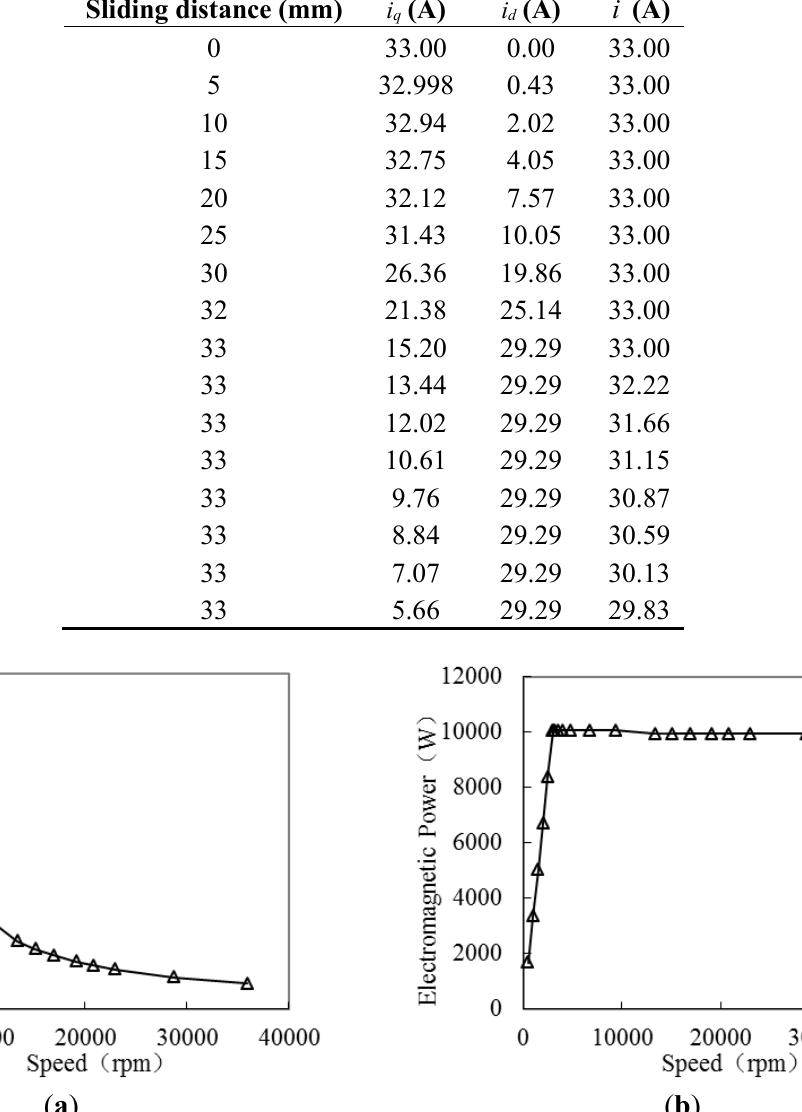
Table 2. The armature root mean square (RMS) current above base speed.